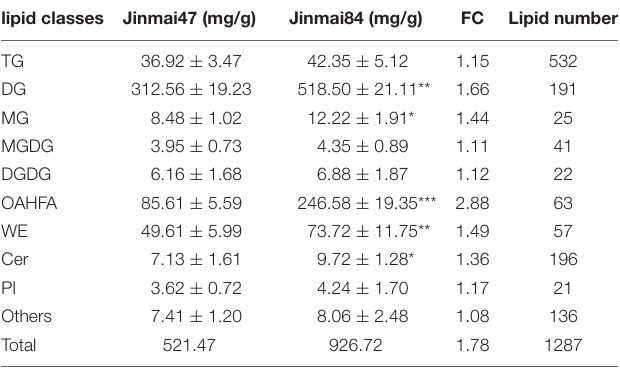
TABLE 1 | Wax content are means ± SD (mg/g).